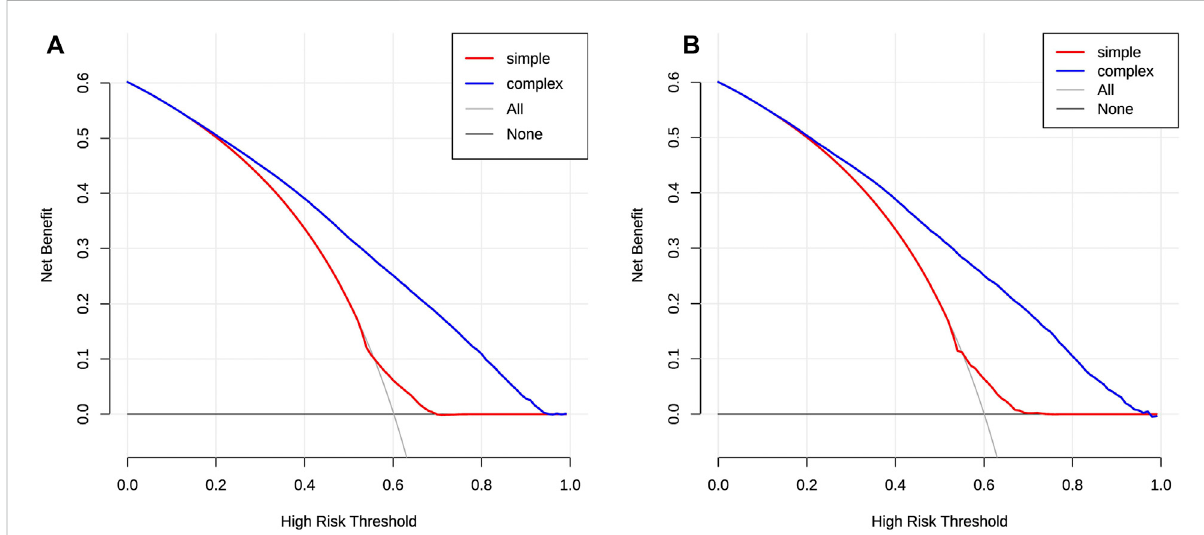
FIGURE 5 DCA of the risk prediction model for polypharmacy in the elderly. The y -axis is the net bene fi t, and the x -axis is the threshold probability. The black solid line indicates the assumption that non-participants have polypharmacy, and the gray solid line indicates the assumption that all participants have polypharmacy. The blue thick solid line represents thecomposited model, combined with the eight factors. The red thick solid line represents a simple model that contains only a single risk factor. In general, the farther the model curve is from the xy-axis, the stronger its clinical practicability is [ (A) : training set; (B) validation